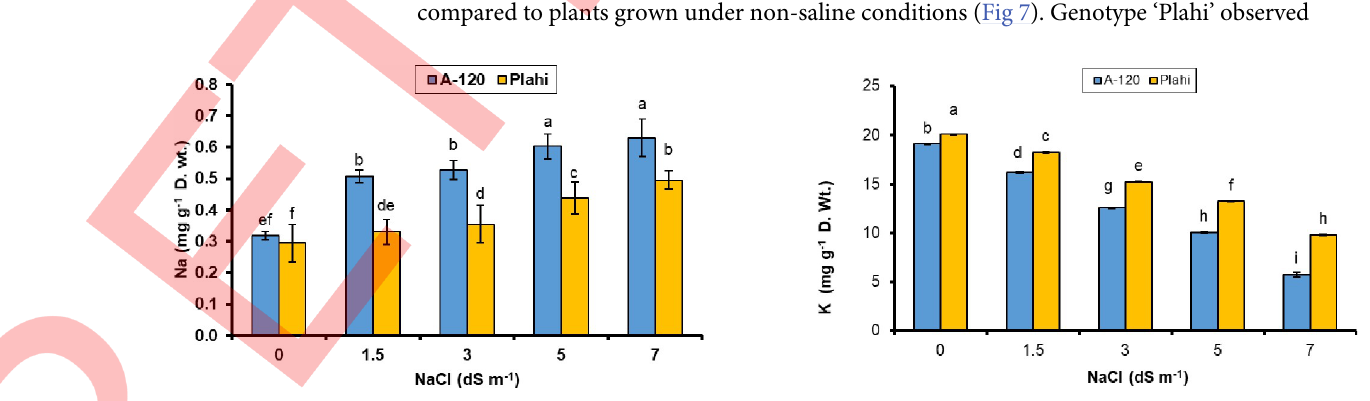
Fig 7. Effect of NaCl stress on ionic contents (sodium & potassium) of two chili genotypes.